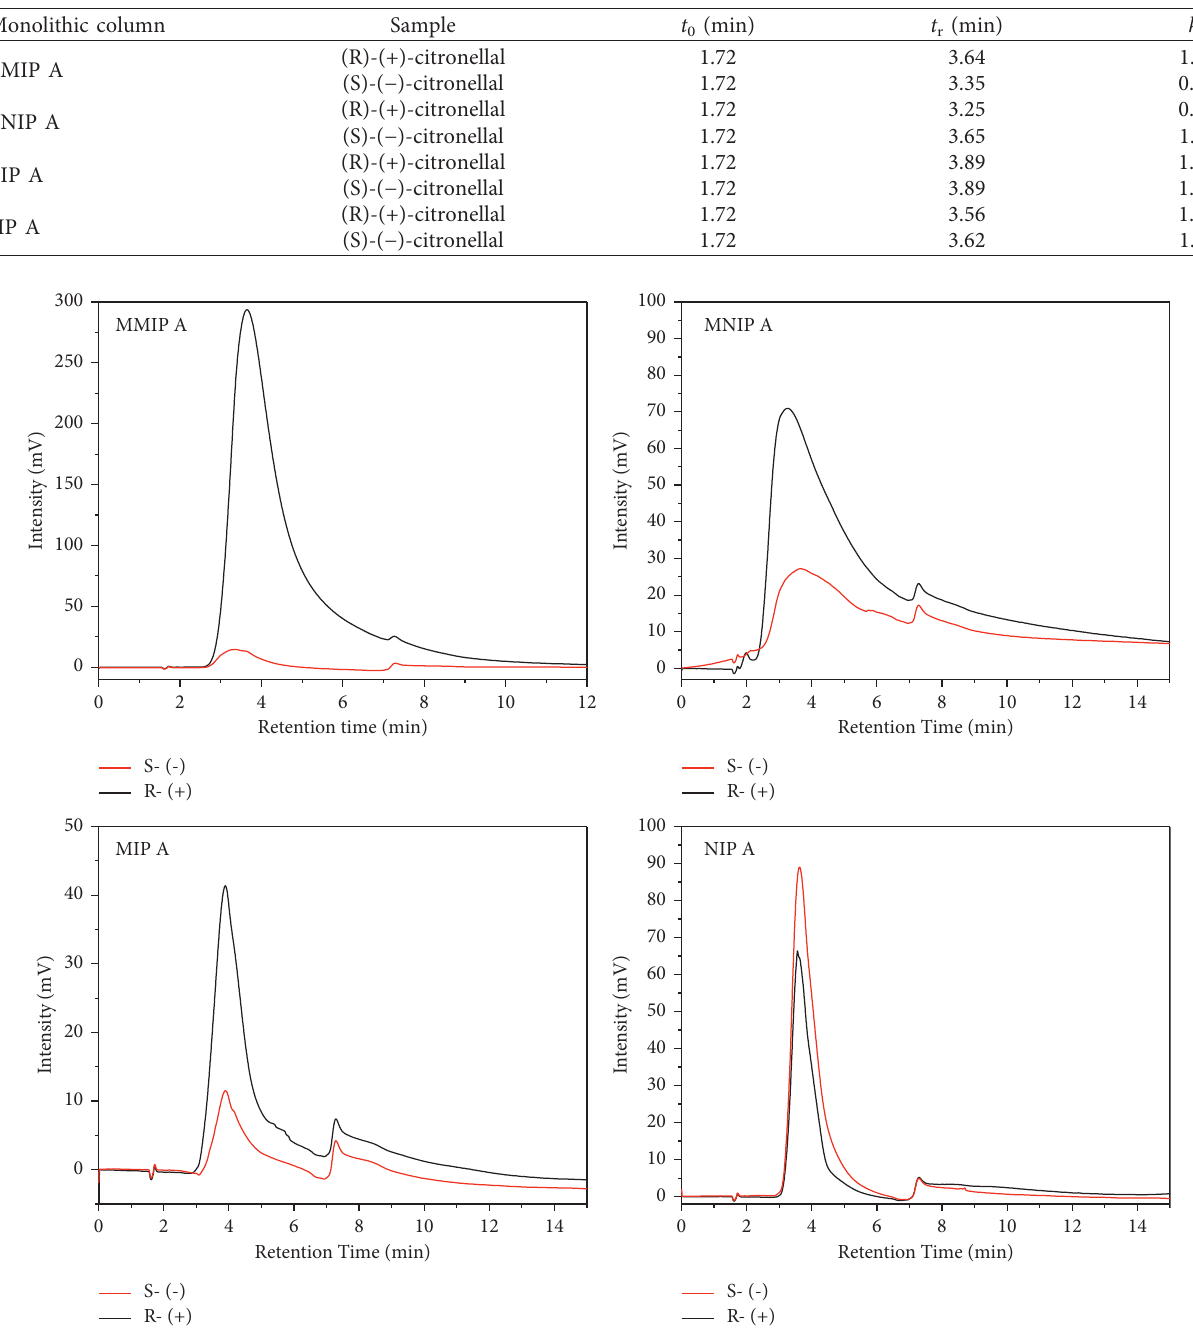
Table 4: The isocratic elution of (R)-(+)-citronellal and (S)-( − )-citronellal using 10% ACN (in water) using MMIP, MNIP, MIP, and NIP monoliths with TRIM as a crosslinker.